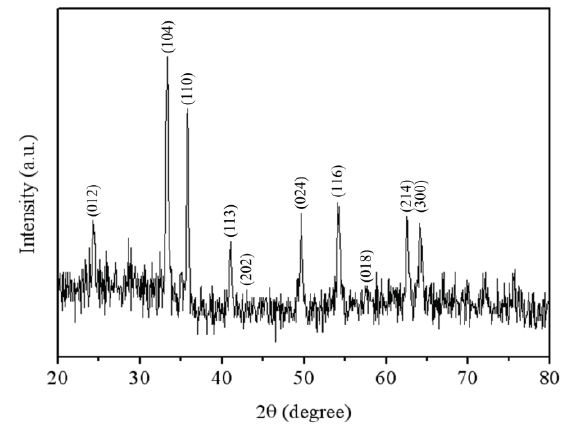
Figure 6. Elements of the α -Fe